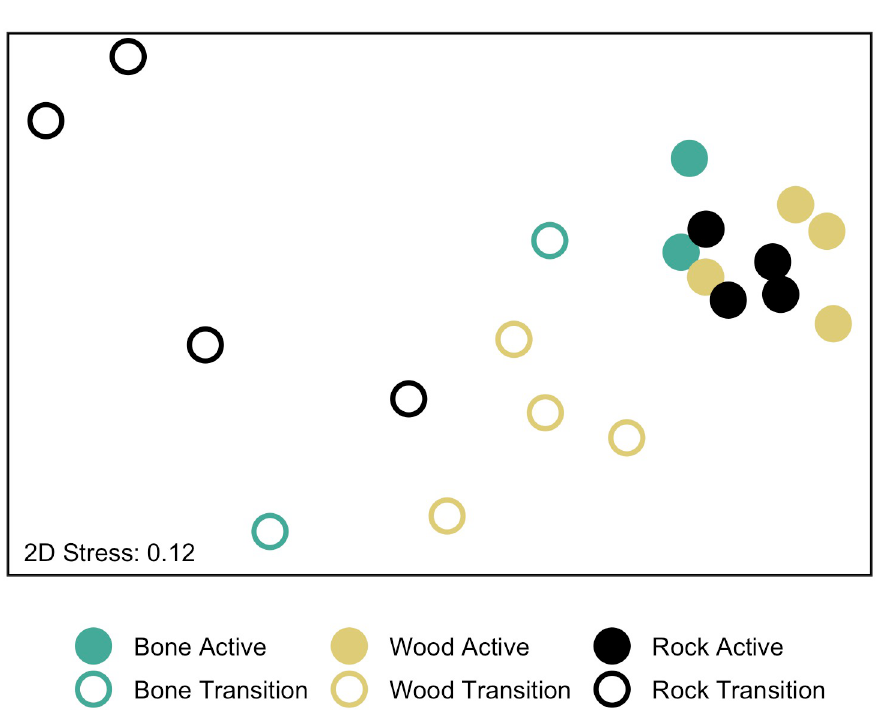
Fig 6. MDS of macrofaunal colonizers on the experimental substrates. Multi-dimensional scaling analysis of macrofaunal invertebrate community composition on experimental cow bone, wood, and carbonate rock deployed for 7.4 years (2010–2017) at active (filled circles) and transition (open circles) sites at Mound 12.